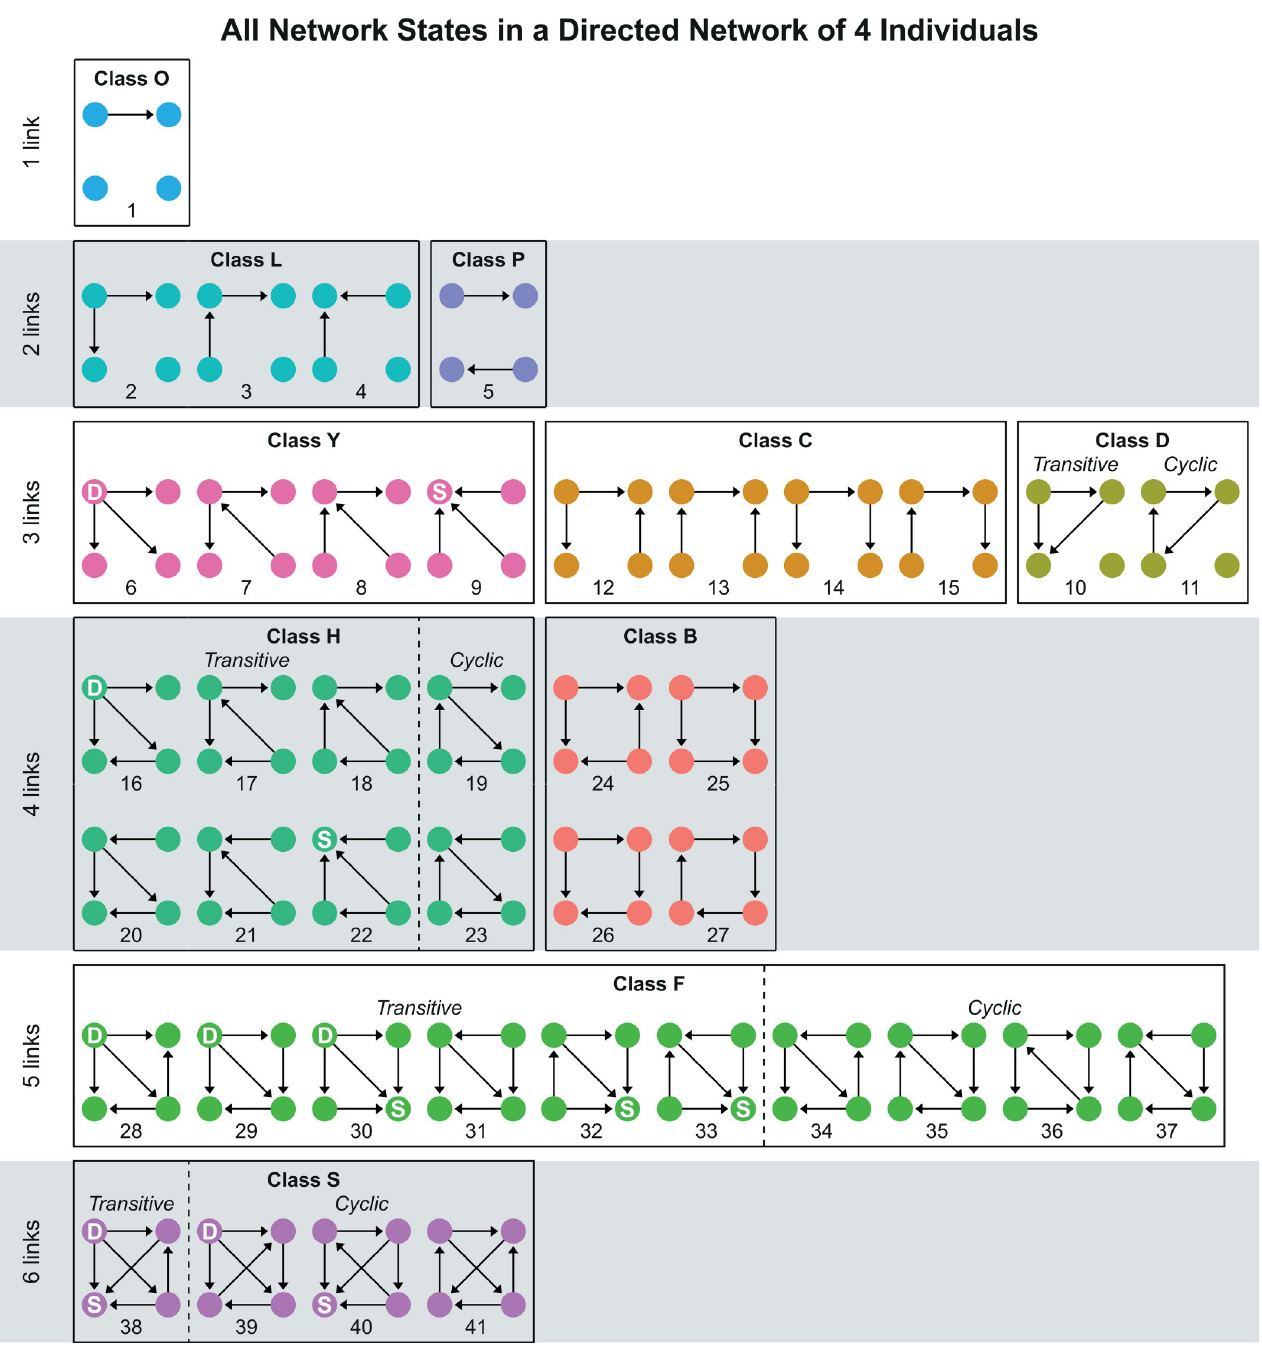
Fig 2. All states of a directed network of four individuals. The states are categorised by number of links (edges), by class and transitivity, following [21]. Note that the colours of the classes correspond to the colours in Fig 7. A node marked with a ‘D’ is an individual that Dominates All Others (DAO), and marked with an ‘S’ is an individual Submissive to All Others